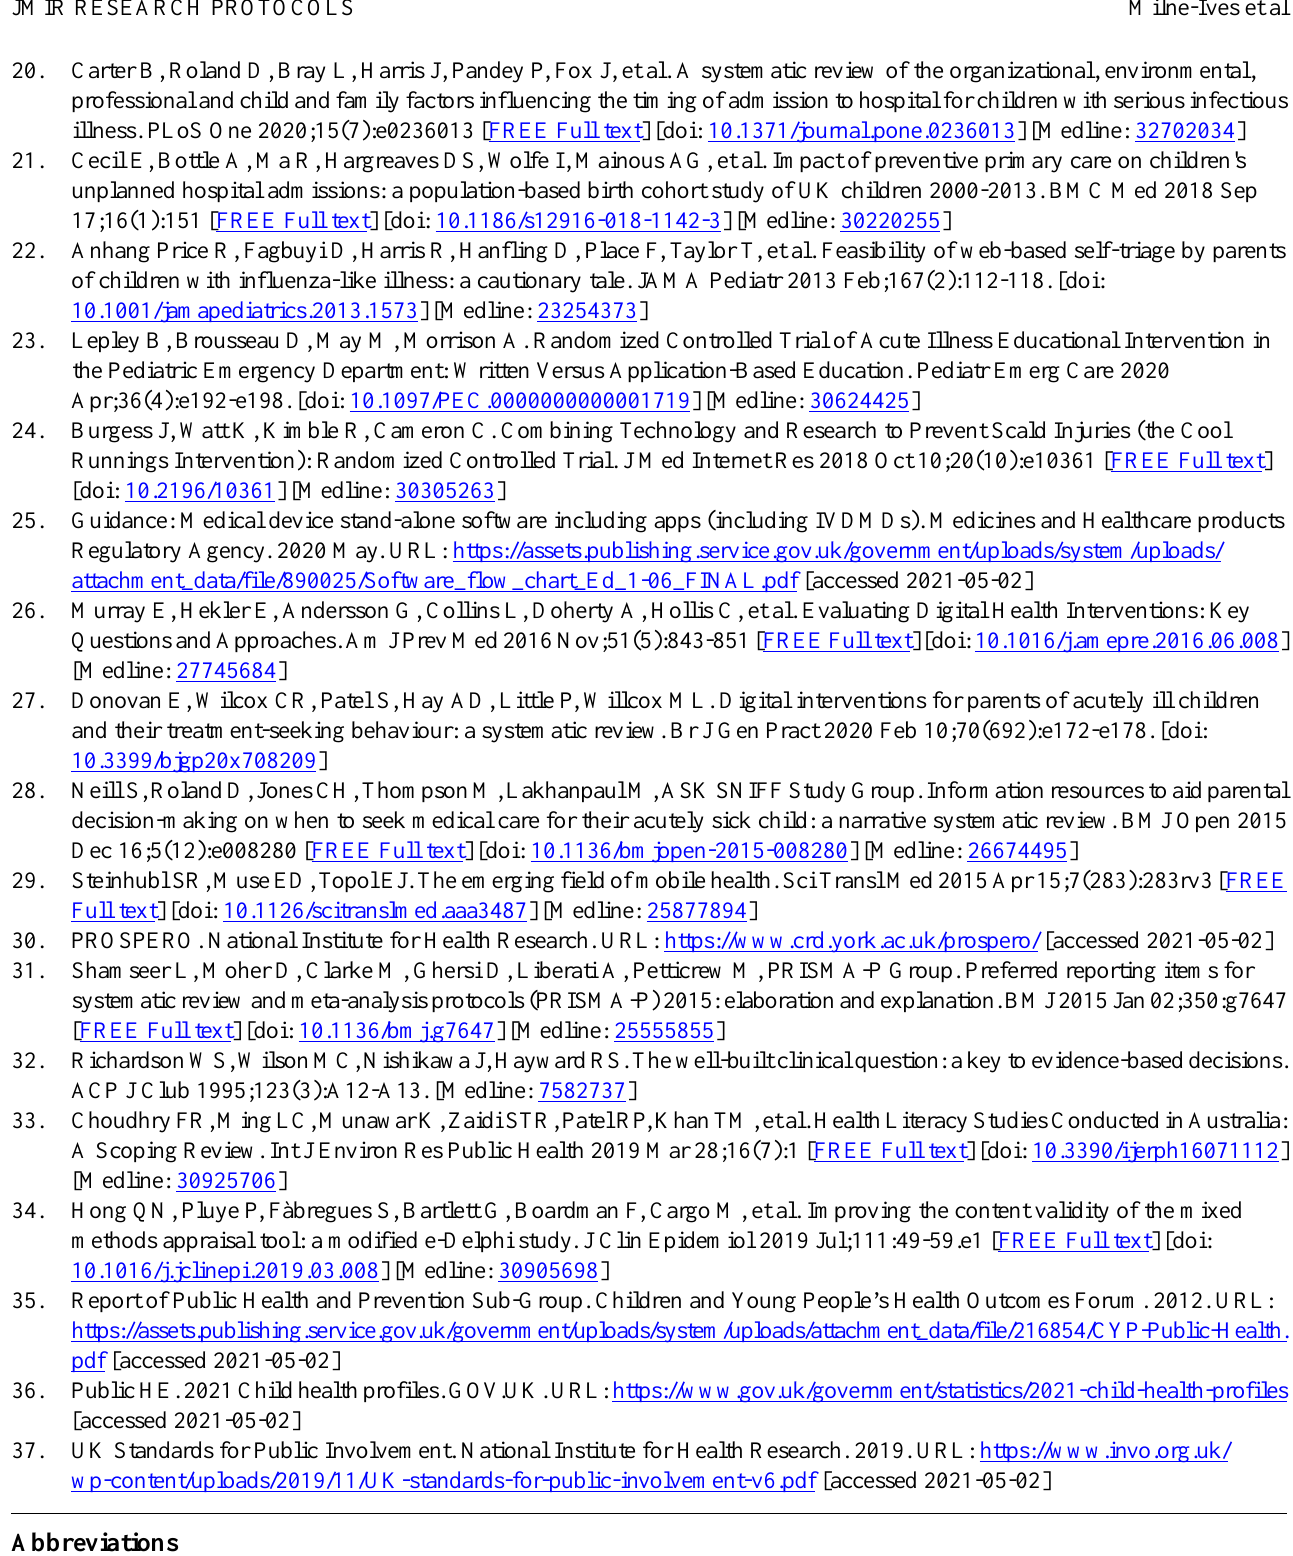
A&E: Accident and Emergency MeSH: Medical Subject